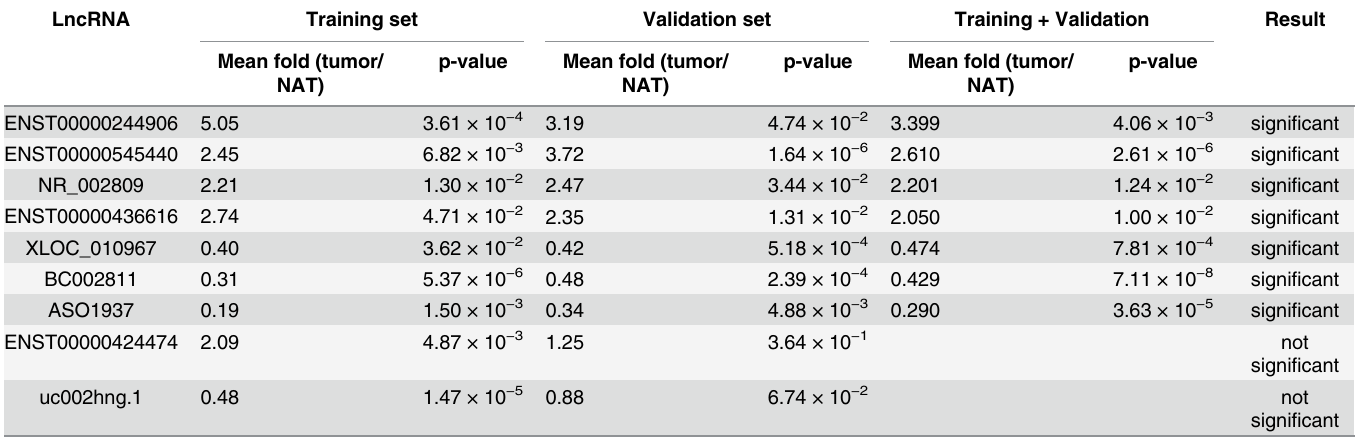
Table 2. Validation by qRT-PCR of differentially expressed lncRNAs in astrocytoma samples compared to NAT samples.